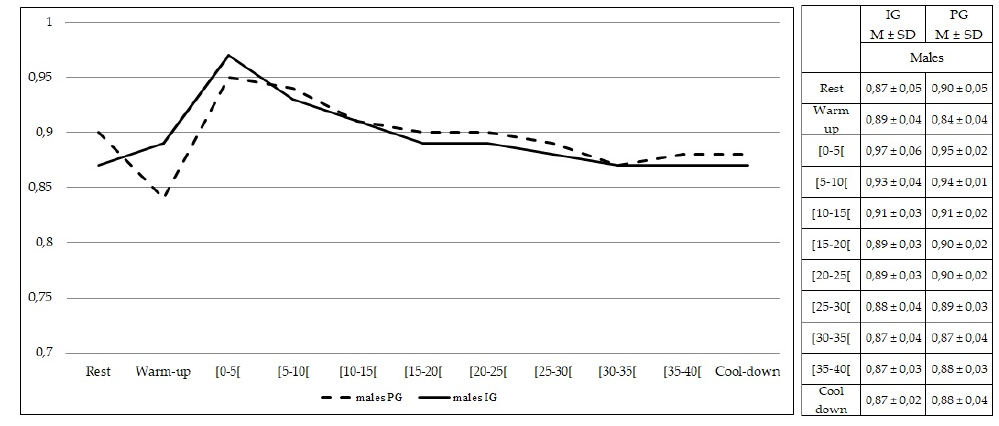
Figure 12. Respiratory exchange ratio values during rest, exercise, and cool-down in males (intervention group vs. placebo group). Data are expressed as mean ± standard deviation. IG: intervention group; PG: placebo group.